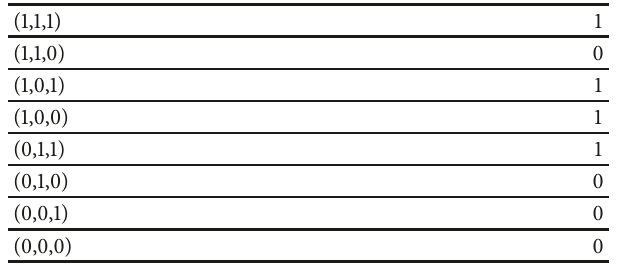
Table 1: Rule table for the elementary CA